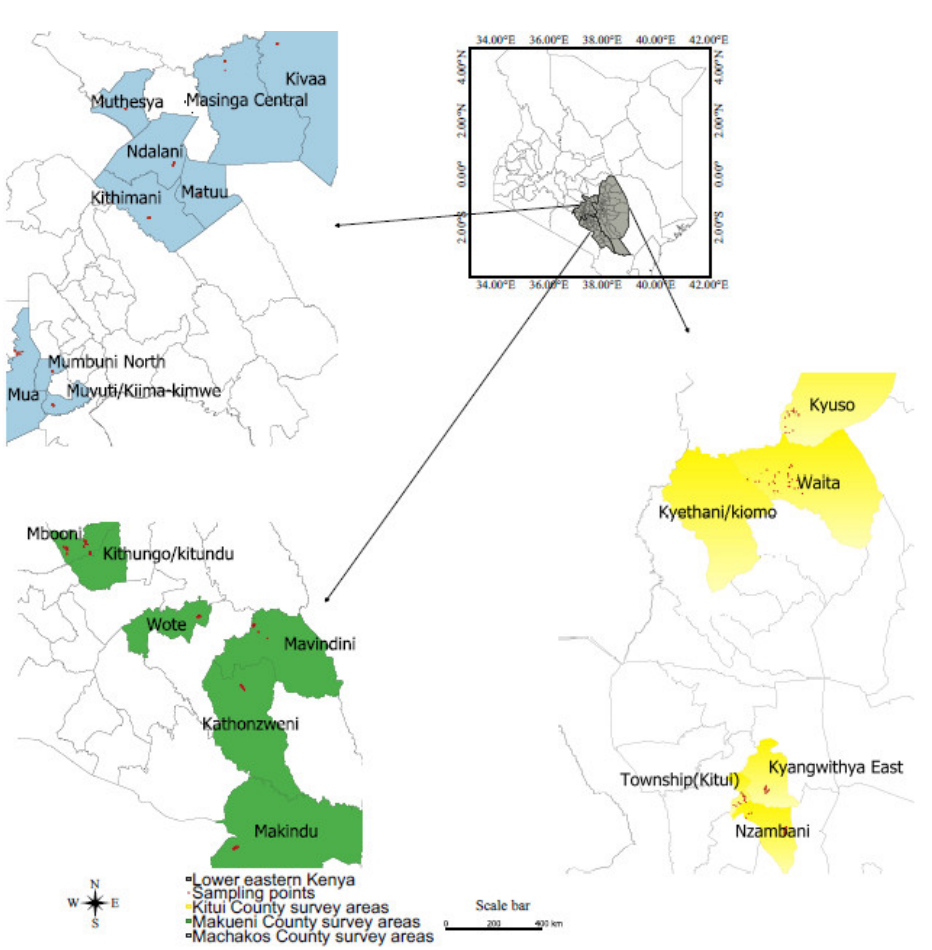
Figure 1. Map showing regions and locations of sorghum fields sampled during the survey between May and September, 2019.